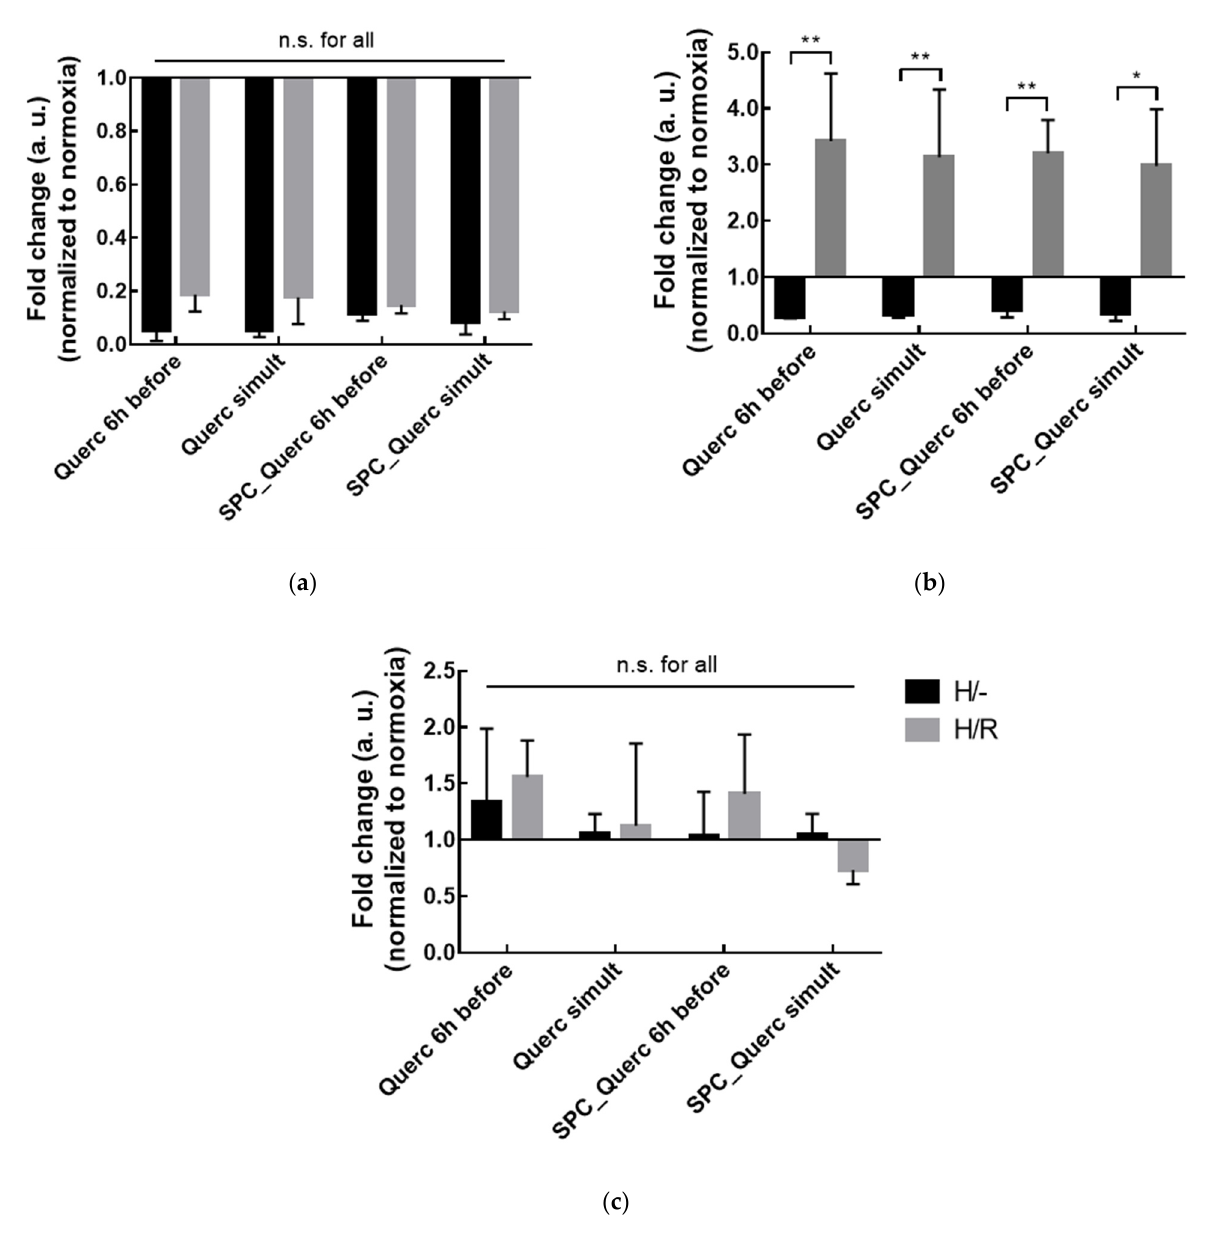
Figure 8. Fold change in TNF- α ( a ), IL-6 ( b ), or IL-10 ( c ) levels in HepG2 cells incubated with 10 µM of free quercetin (Querc) or quercetin liposomes (SPC_Querc) added 6 h before or simultaneously with the hypoxia onset (simult). The biomarkers were analyzed at the end of the hypoxia period (H ‒ or after the 4 h reperfusion period (H/R). Results presented as mean ± SD of the fold change, where each condition was normalized to vehicle control in normoxia—cells incubated with 0.1% DMSO or unloaded-liposomes were used as Querc or SPC_Querc controls, respectively ( n = 4). * p < 0.05 and ** p < 0.01; n.s., statistically non-significant (H/ ‒ vs. H/R and free vs. liposomal quercetin in the same condition).